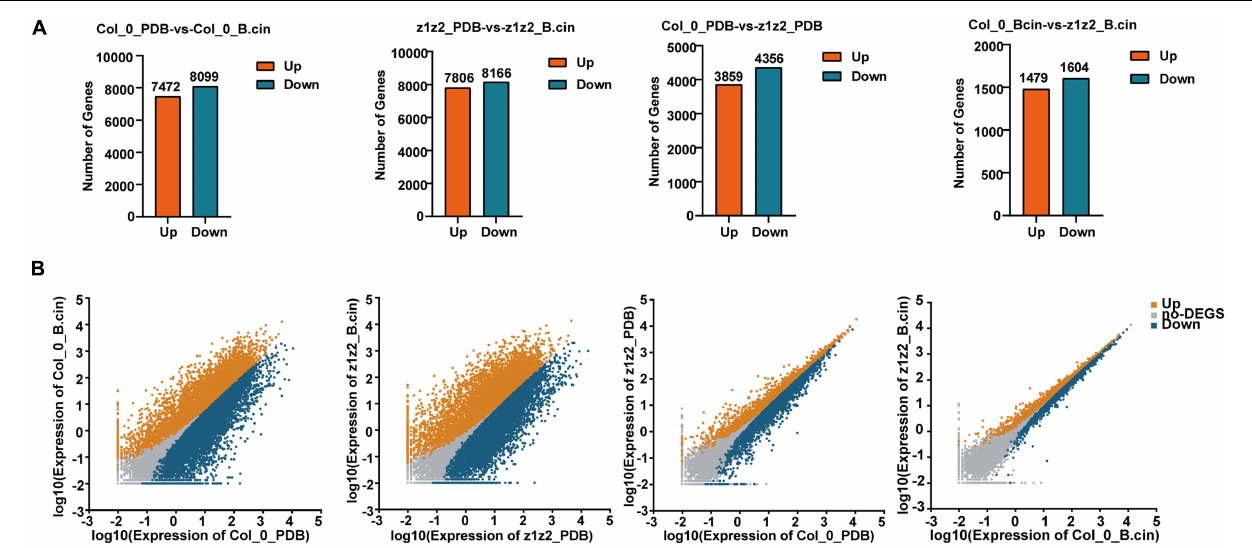
FIGURE 4 | Data analysis of RNA-sequencing. (A) RNA-sequencing was performed in Col-0 and zar1-3zar2-1 double mutant after 28 h of treatment with B. cinerea spray or PDB. Each treatment contained three biological replicates. Total RNAs derived from Col-0 or zar1-3zar2-1 double mutant plants upon B. cinerea infection or PDB were compared between different genotypes or treatment conditions. Numbers of up- and down-regulated genes were illustrated ( P- value < 0.05, fold change > 2). z1z2_PDB: zar1-3zar2-1 double mutant plants treated with PDB; z1z2_B.cin: zar1-3zar2-1 double mutant plants treated with B. cinerea ; Col_0_PDB: Col-0 plants treated with PDB; Col_0_B.cin: Col-0 plants treated with B. cinerea . (B) The scatter plots illustrate differentially expressed genes between Col-0 and zar1-3 zar2 double mutant. Genes up-regulated, down-regulated, or unchanged were shown in orange, blue, or gray, respectively. | log2FC| > 1 and FDR < 0.05 were set as a cut